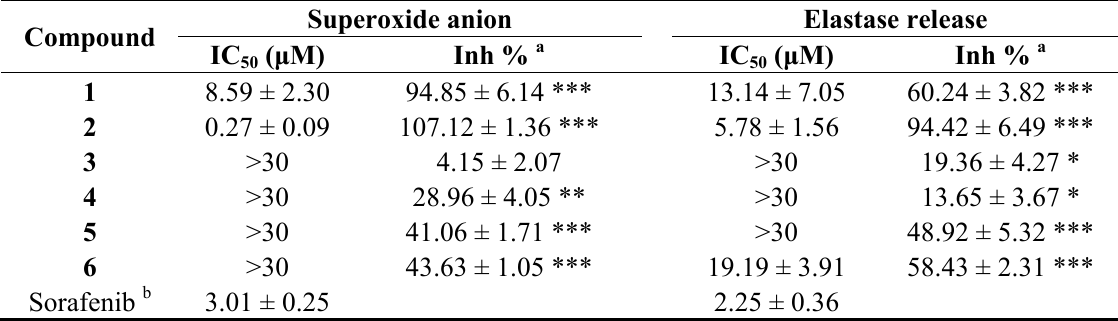
Table 2. Effects of compounds on superoxide anion generation and elastase release by human neutrophils in response to FMLP/CB.